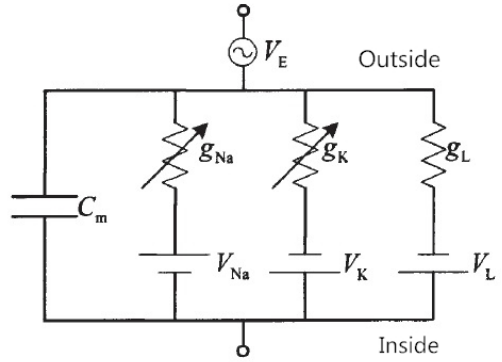
Figure 1. Circuit description of the H-H